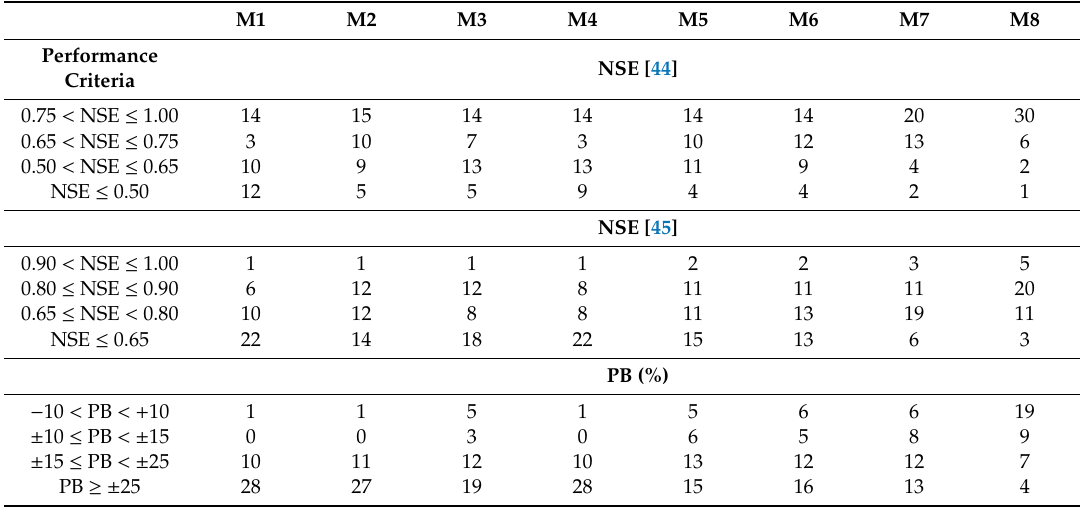
Table 4. Performance of the CN model and its variants in 39 watersheds in the study area.